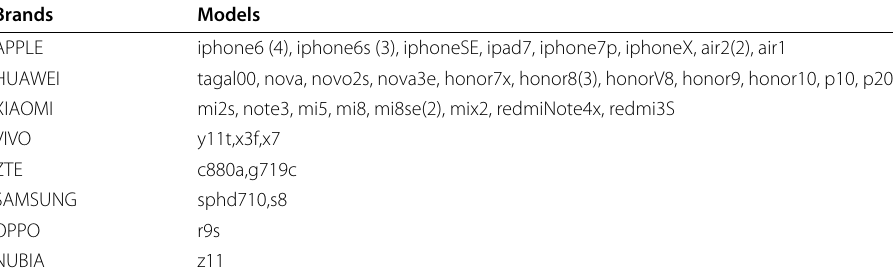
Table 2 Brands and models of the CCNU-Mobile